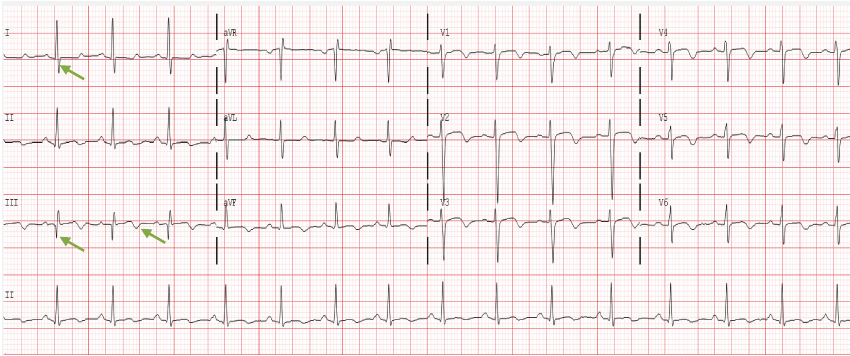
Figure 1: 12 lead ECG on admission showing sinus rhythm 95 bpm with S 1 Q 3 T 3 pattern (prominent S wave in lead I, Q wave and inverted T wave in lead III, green arrows).